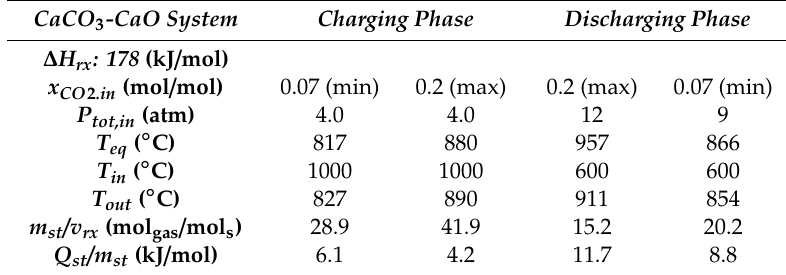
Table 7. TCS operating conditions for the carbonate-based system (CaCO 3– Ca) applied to a closed loop TCS unit.